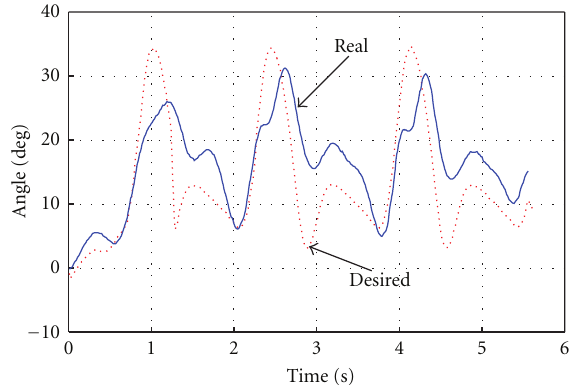
Figure 16: Real and desired knee joint angle of bionic leg during